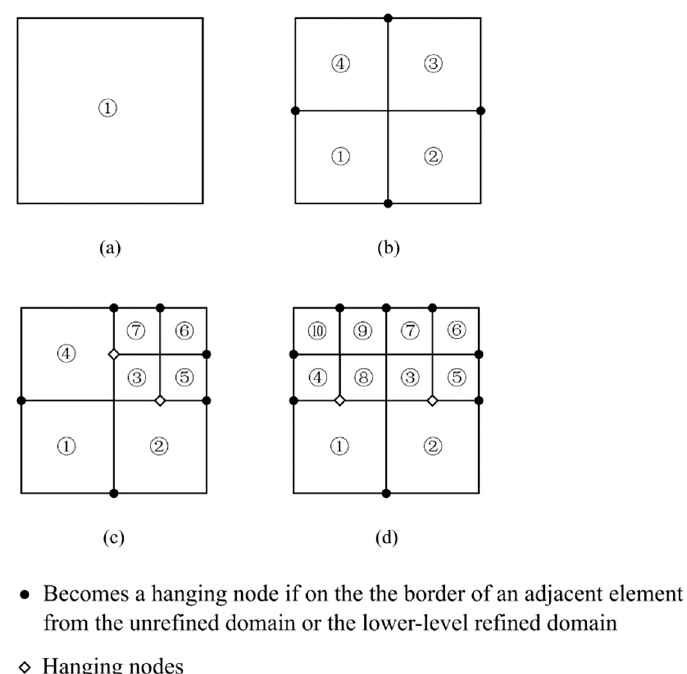
Figure 3. ( a ) A parent element before refinement; ( b ) Four sibling elements replacing the parent element; ( c ) One sibling element becomes a parent element for four sibling elements on the next level; ( d ) Two sibling elements become parent elements for eight sibling elements on the next level.